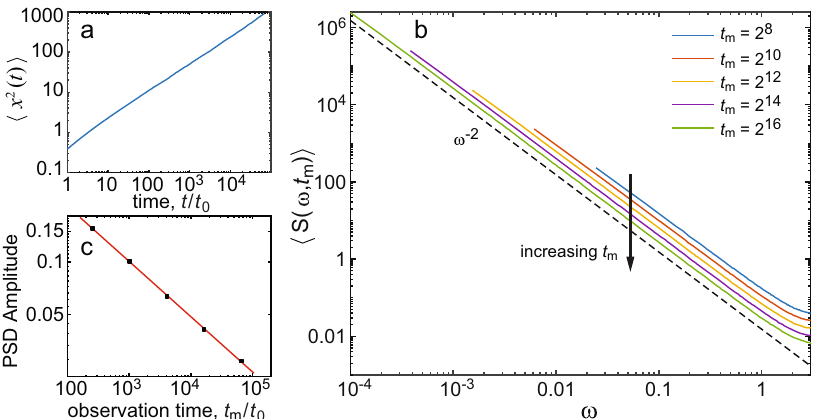
Fig. 2 Numerical simulation of the CTRW, i.e., Brownian motion with power-law waiting times. The simulations were performed for α = 0.7 and 10,000 realizations were obtained. a The MSD shows subdiffusive behavior 〈 x 2 ( t ) 〉 ~ t α , while a linear regression of log ð MSD Þ vs. log ð t Þ indicates 〈 x 2 ( t ) 〉 ~ t 0.69 . The times and displacements are unitless, i.e., the simulation sampling time is 1. b PSD at fi ve different measurement times exhibits aging. The power law asymptotic S ~ ω − 2 is indicated with a dashed line. The arrow shows the decay in the PSD with measurement time t m . c The amplitude A ( t m ) of the PSD, where 〈 S 〉 = A ( t m )/ ω 2 , shows A ð t m Þ (cid:2) t (cid:3) 0 : 31 , highlighting the aging effect, in excellent agreement with theory which predicts A ð t m Þ (cid:2) t (cid:3)ð 1 (cid:3) α Þ m